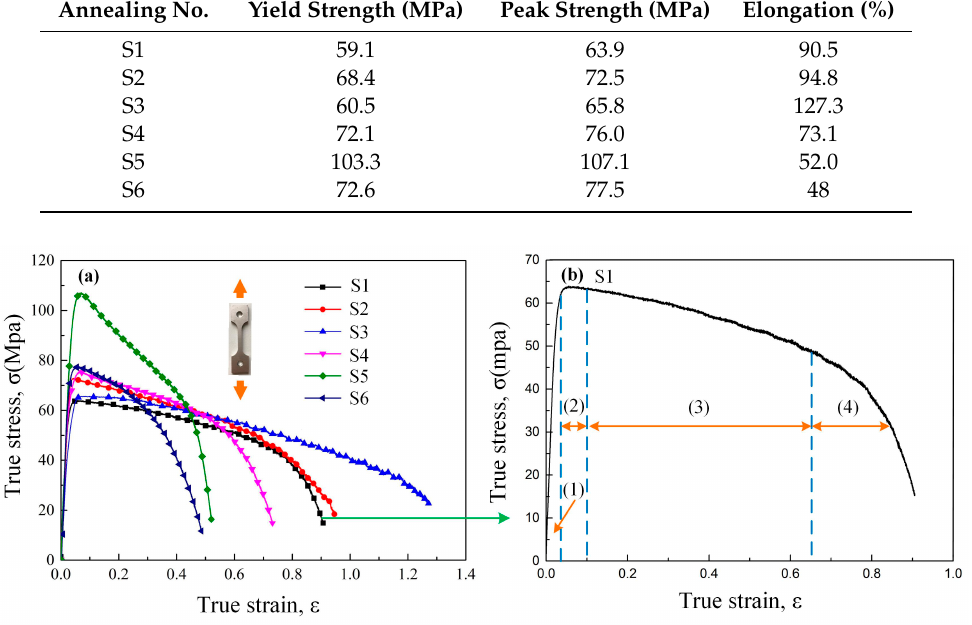
Figure 6. ( a ) The 900°C flow curves of TA17 with different microstructures. ( b ) Four parts of the typical true σ - ε curve.